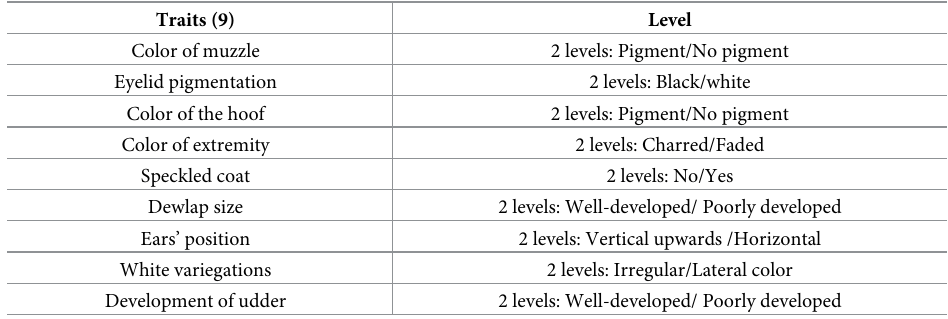
Table 1. List of measured qualitative traits with the different levels of characterization. Traits (9) Level Eyelid pigmentation Color of the hoof Speckled coat 2 levels: No/Yes Dewlap size 2 levels: Well-developed/ Poorly developed Ears’ position 2 levels: Vertical upwards /Horizontal White variegations 2 levels: Irregular/Lateral color Development of udder 2 levels: Well-developed/ Poorly